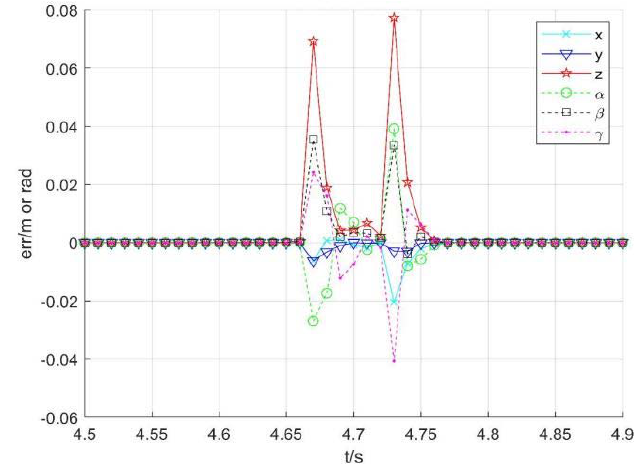
Figure 9. The tracking errors of position and orientation.